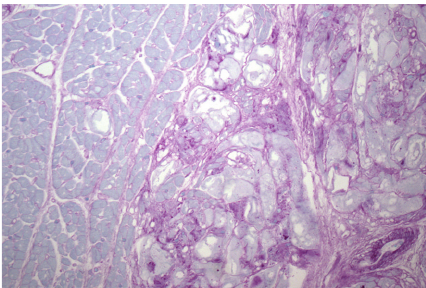
Figure 3: Heart; bearded seal. PAS positive granular material con- sistent with glycogen is present in the cytoplasm of neoplastic but not normal myocardium. PAS.